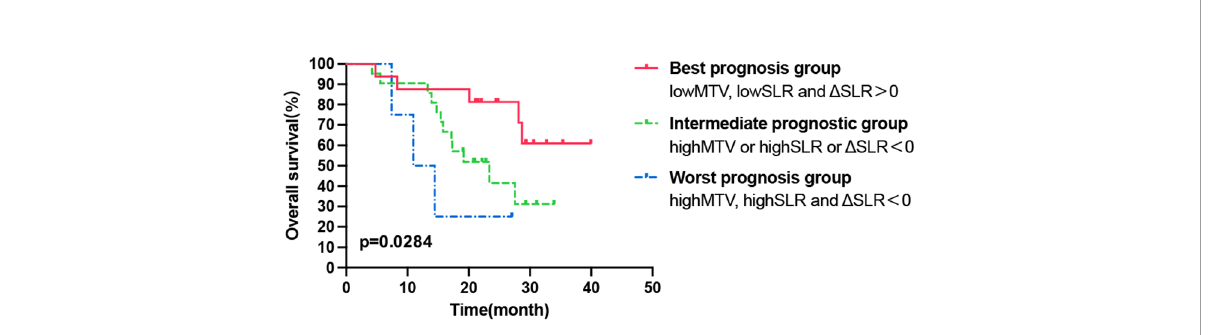
FIGURE 4 Kaplan – Meier curve of OS according to the combination of tumor and secondary lymphoid organ metabolic markers. OS, overall